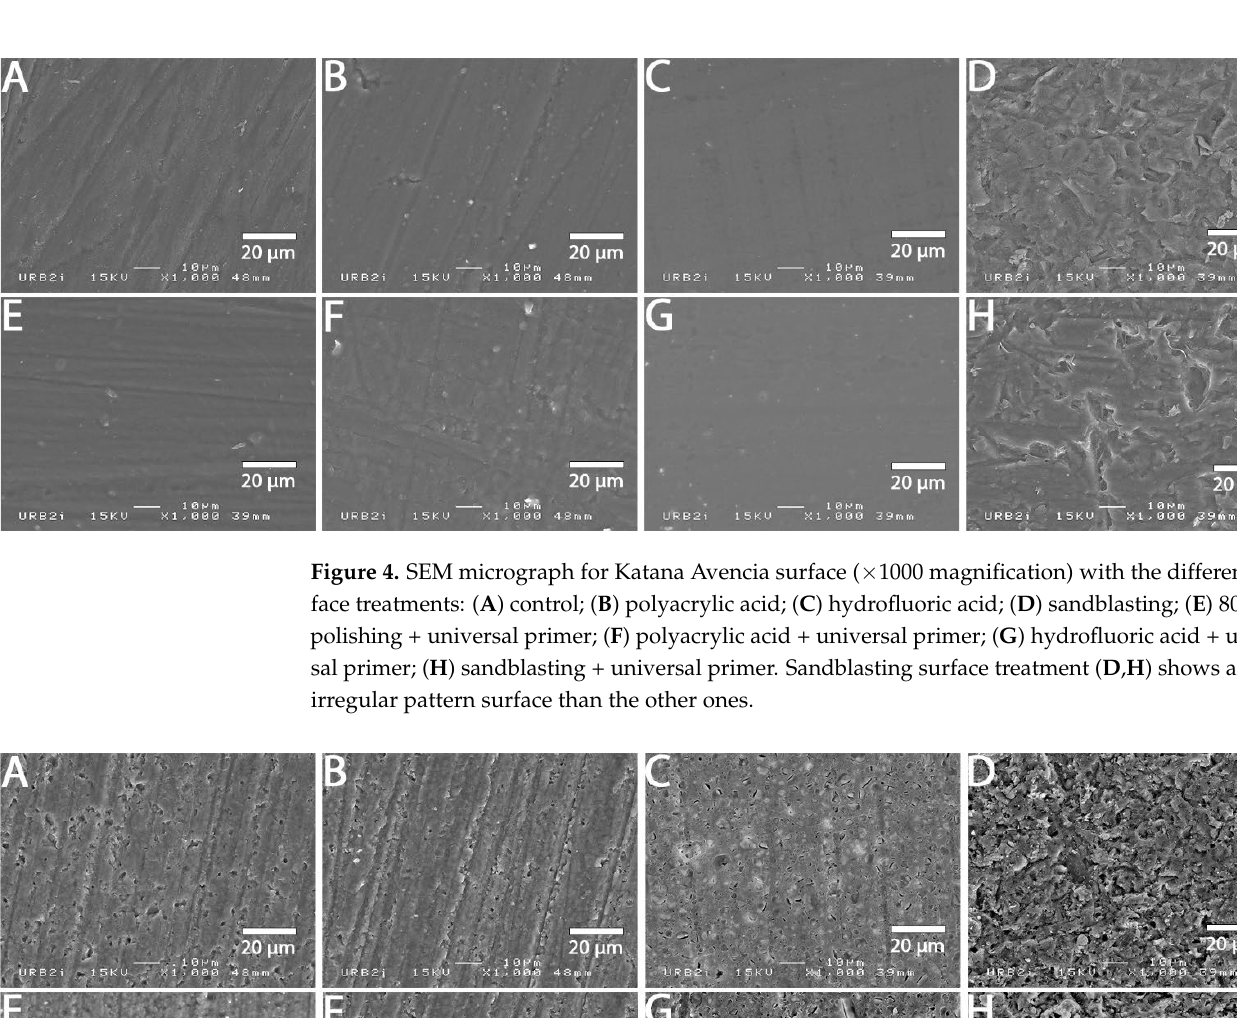
Figure 3. SEM micrograph for Grandio block surface (×1000 magnification) with the different sur- face treatments: ( A ) control; ( B ) polyacrylic acid; ( C ) hydrofluoric acid; ( D ) sandblasting; ( E ) 800 grit polishing + universal primer; ( F ) polyacrylic acid + universal primer; ( G ) hydrofluoric acid + uni- versal primer; ( H ) sandblasting + universal primer. Sandblasting surface treatment ( D , H ) shows a deeper and more irregular pattern surface than the other ones.